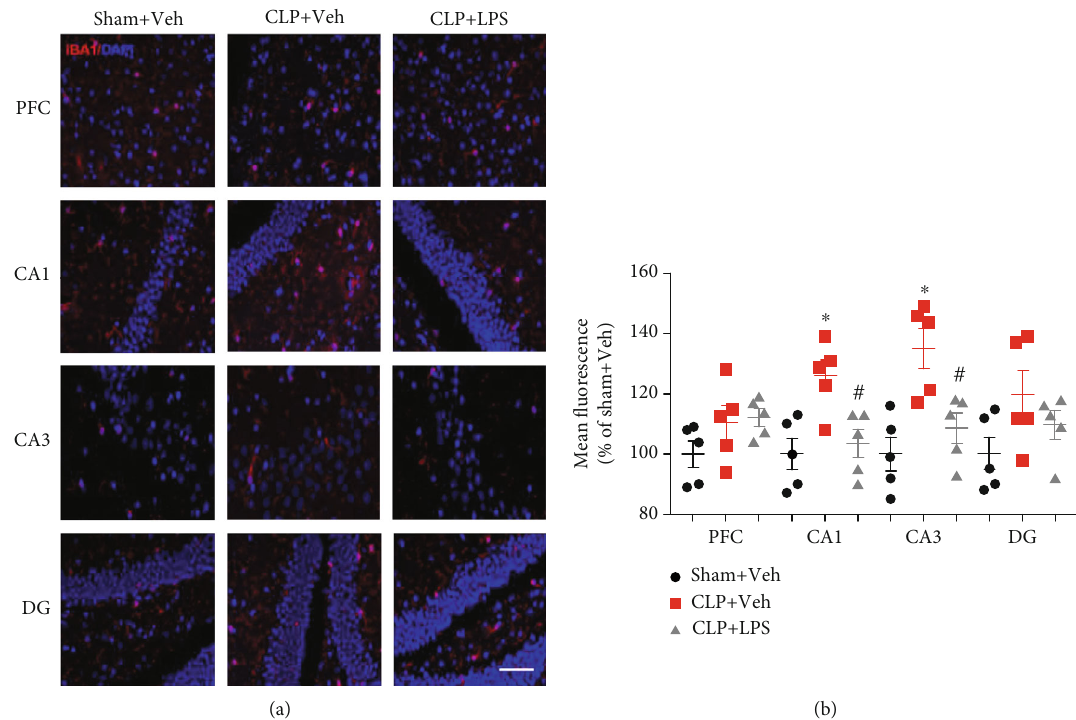
Figure 7: E ff ects of repeated LPS injections and CLP on IBA1-positive cells. Immunohistochemistry showed increased intensity of IBA1- positive in the CA1 and CA3 following CLP, which were partially prevented by repeated LPS injections. Data represent mean ± SEM ; n = 5 /group. ∗ P < 0 : 05 vs. sham + Veh group; # P < 0 : 05 vs. CLP+Veh group. LPS: lipopolysaccharide; CLP: cecal ligation and puncture; Veh: vehicle; PFC: prefrontal cortex; CA1: cornu ammonis 1; CA3: cornu ammonis 3; DG: dentate gyrus. Red indicates IBA1; blue indicates DAPI; scale bar = 100 μ m .